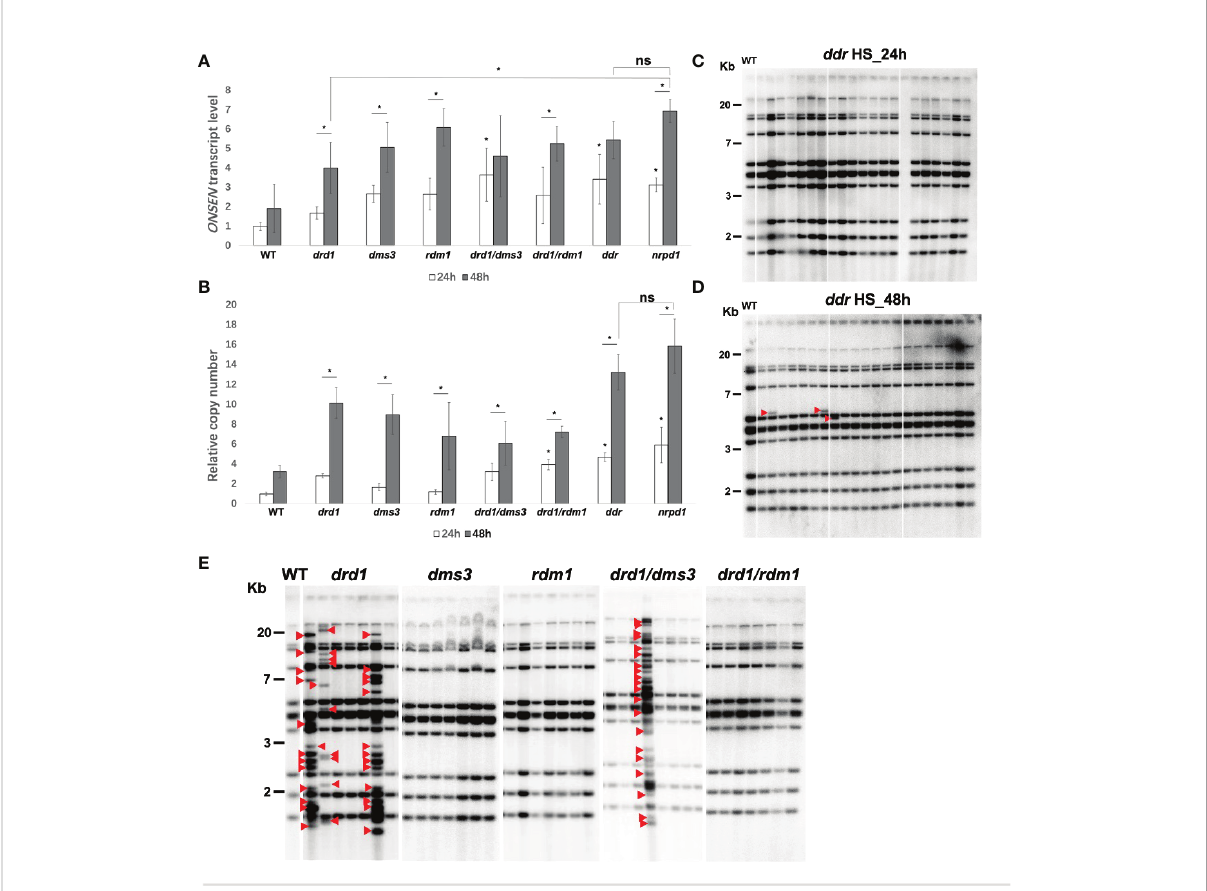
FIGURE 3 ONSEN activation in DDR complex-associated mutants subjected to heat stress (HS). (A, B) Comparative analysis of the expression level (A) and copy number (B) of ONSEN after 24 and 48 h of HS in wild type, nrpd1 , and the DDR complex-associated mutants (Student ’ s t-test, P < 0.05). Asterisks indicate signi fi cant differences between the 24 and 48 h HS conditions (Student ’ s t-test, P < 0.05). ns indicates not signi fi cant. (C, D) Detection of transposition of ONSEN in the next generation (F2) plants of the ddr mutant after 24 h (C) and 48 h (D) HS. Seven individuals of the next generation from each of the three parent plants subjected to heat stress were analyzed by Southern blotting. Red arrows indicate new ONSEN insertions. (E) Southern blot analysis of ONSEN in the next generation plants of drd1, dms3, rdm1, drd1/dms3 , and drd1/rdm1 mutants after 48 h of HS. Seven individuals of the next generation from each of the parent plants subjected to heat stress were analyzed. Red arrows indicate new ONSEN